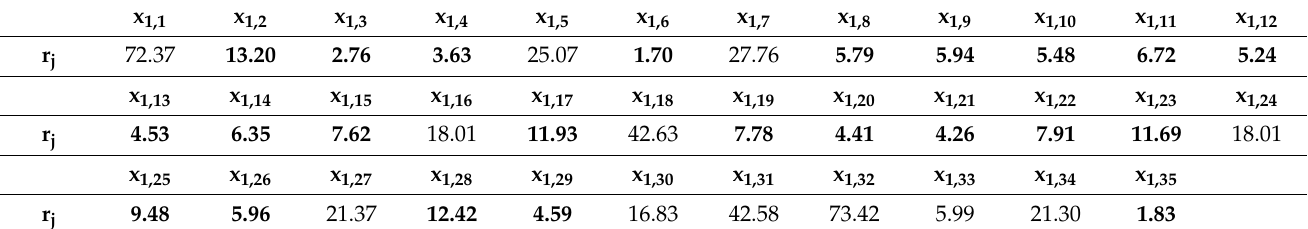
Table 3. Distance values r j ( x i